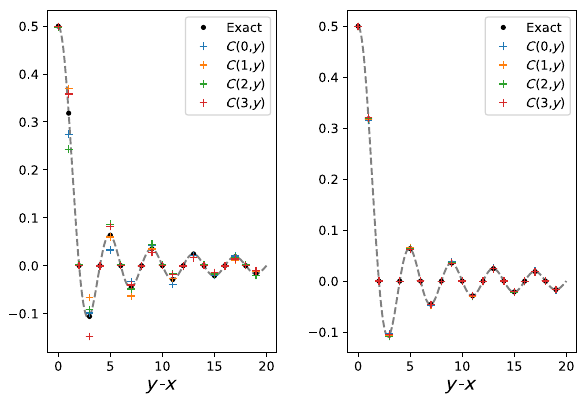
FIG. 10. Two-point function C ð x; y Þ of the approximate ground states in one dimension for wavelet parameters K ¼ L ¼ 1 (left panel) and K ¼ L ¼ 3 (right